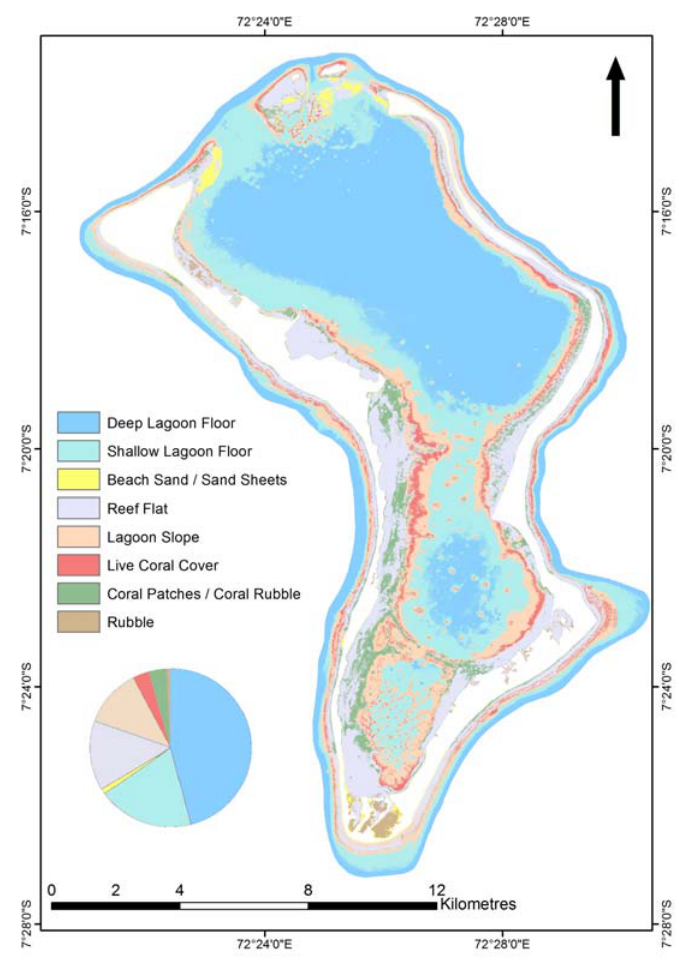
Figure 7. Benthic cover map generated from Ikonos imagery and Purkis et al. ’s [21] ground truth data. The pie chart illustrates the relative proportions of each cover type mapped by the classification.